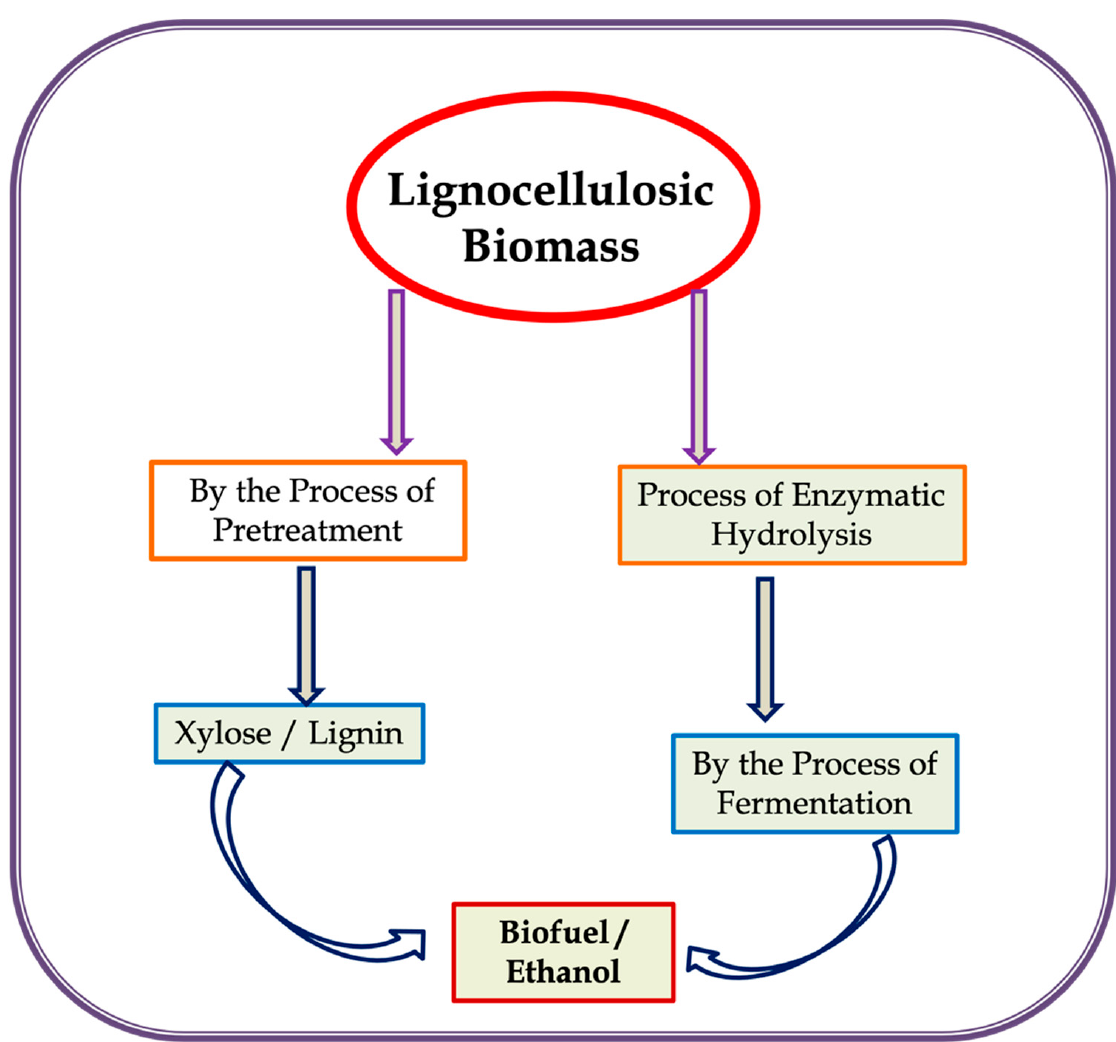
Figure 4. Lignocellulosic biomass conversion. A schematic view (adopted and modified from Naik et al. [13].